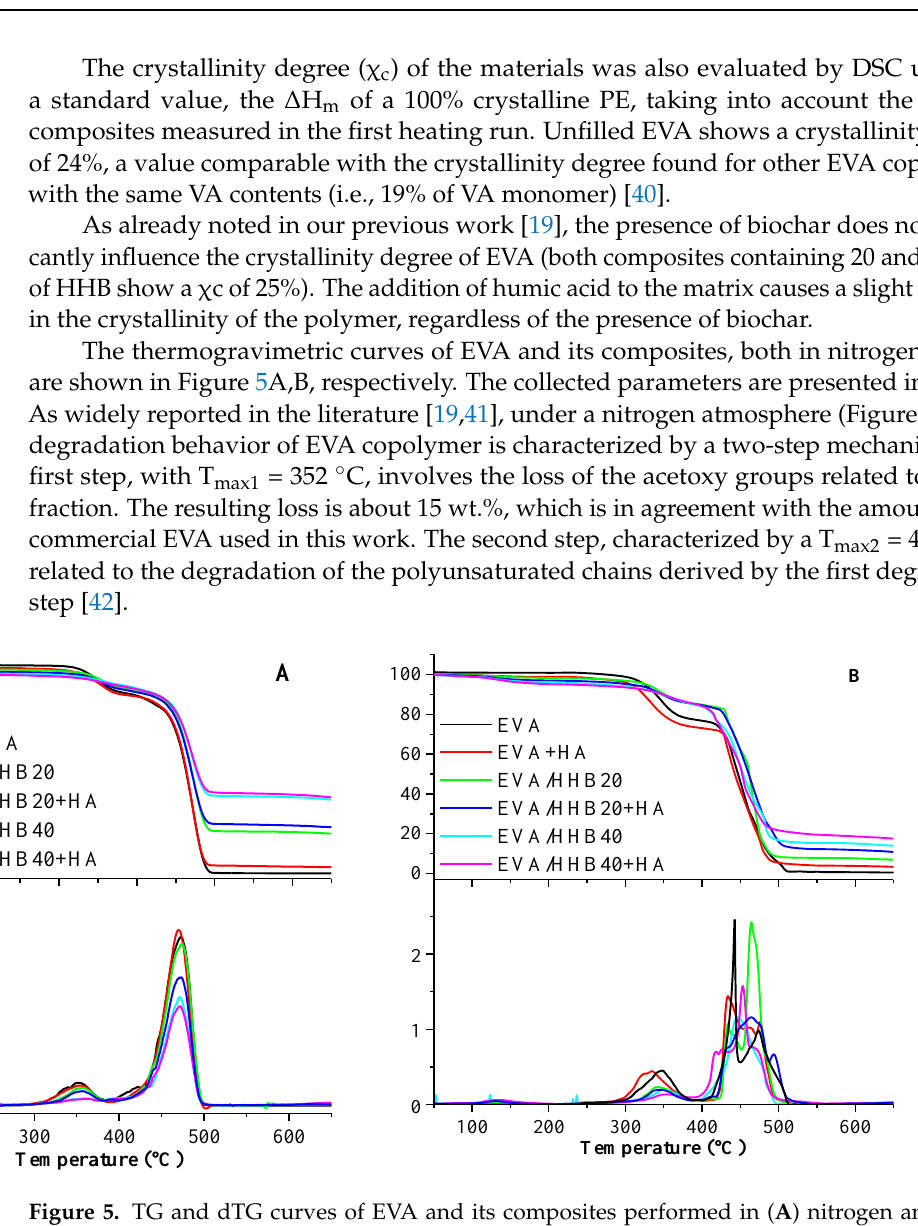
Figure 5. TG and dTG curves of EVA and its composites performed in ( A ) nitrogen and ( B ) air atmosphere. (heating rate: 10 °C/min).